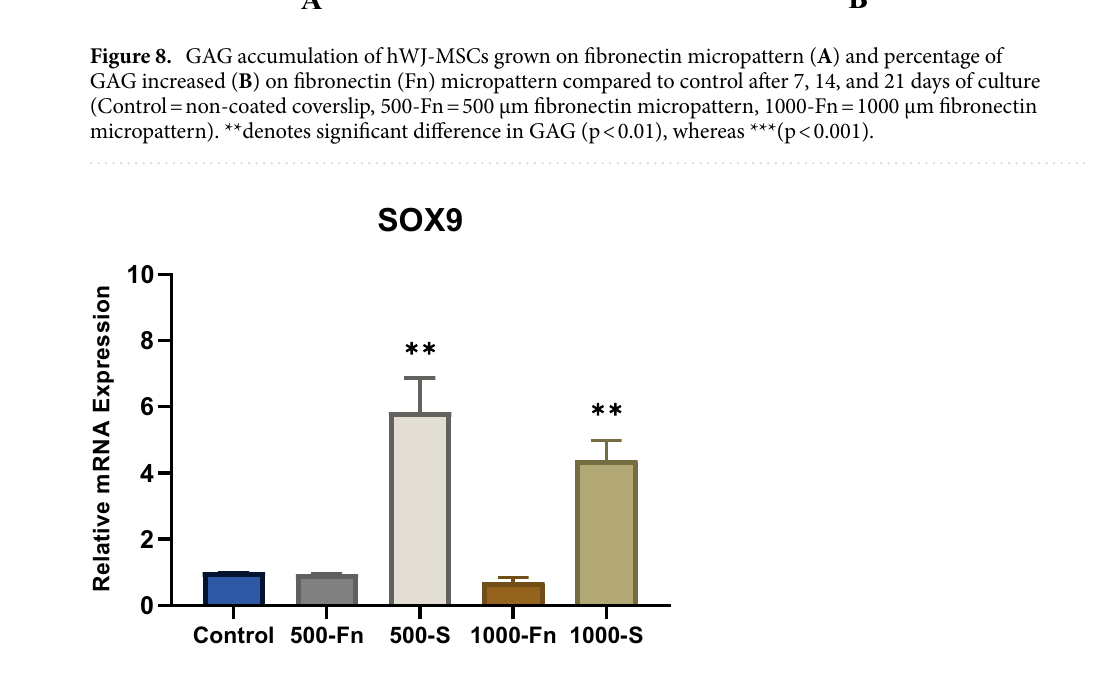
Figure 9. Relative SOX9 mRNA expression of hWJ-MSCs grown on fibronectin and spidroin micropattern after 21 days of culture (Control = non-coated coverslip, 500-Fn = 500 µm fibronectin